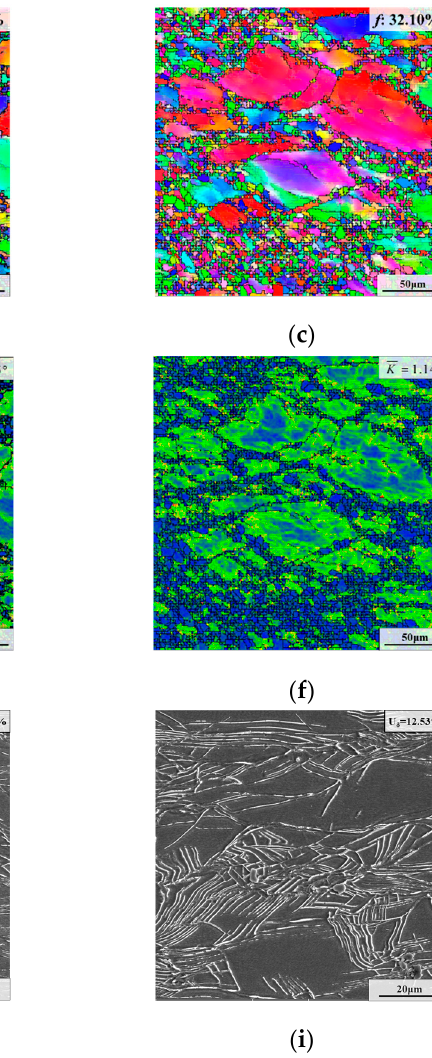
Figure 4. Deformed microstructures with different deformation temperatures of: ( a , d , g ) 950 °C; ( b , e , h ) 980 °C; ( c , f , i ) 1010 °C. (The strain rate is 0.1 s − 1 , and the true strain is 0.69. K represents the average KAM value, and f represents the recrystallized fraction).